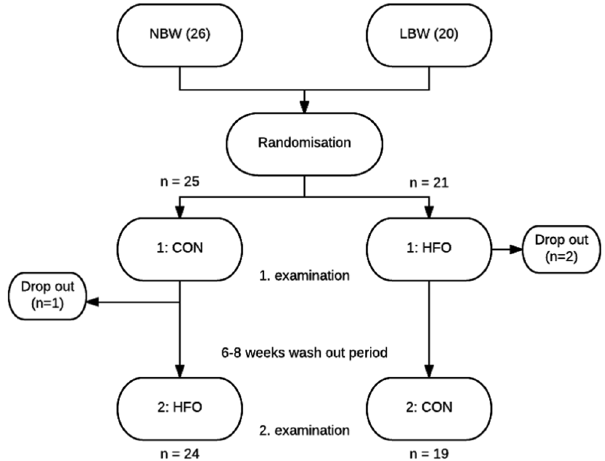
Figure 4. Study design. Flow chart showing the randomised crossover design of the study. The 46 participants were randomised to receive either the control diet before the first examination and high-fat overfeeding before the second examination or to receive the high-fat overfeeding before the first examination and the control diet before the second examination. The two study periods were separated by a 6–8 weeks wash out period. One participant experienced discomfort during the first clamp examination; why it was terminated and not repeated. This participant was excluded. Two participants did not complete the overfeeding intervention and were therefore excluded. CON, control diet; HFO, high-fat overfeeding; LBW, low birth weight; NBW, normal birth